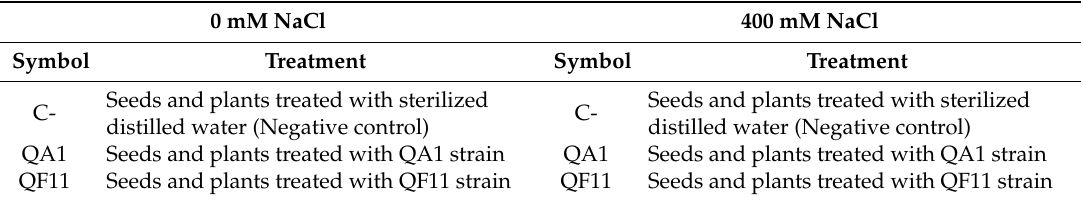
Table 1. Pot study work